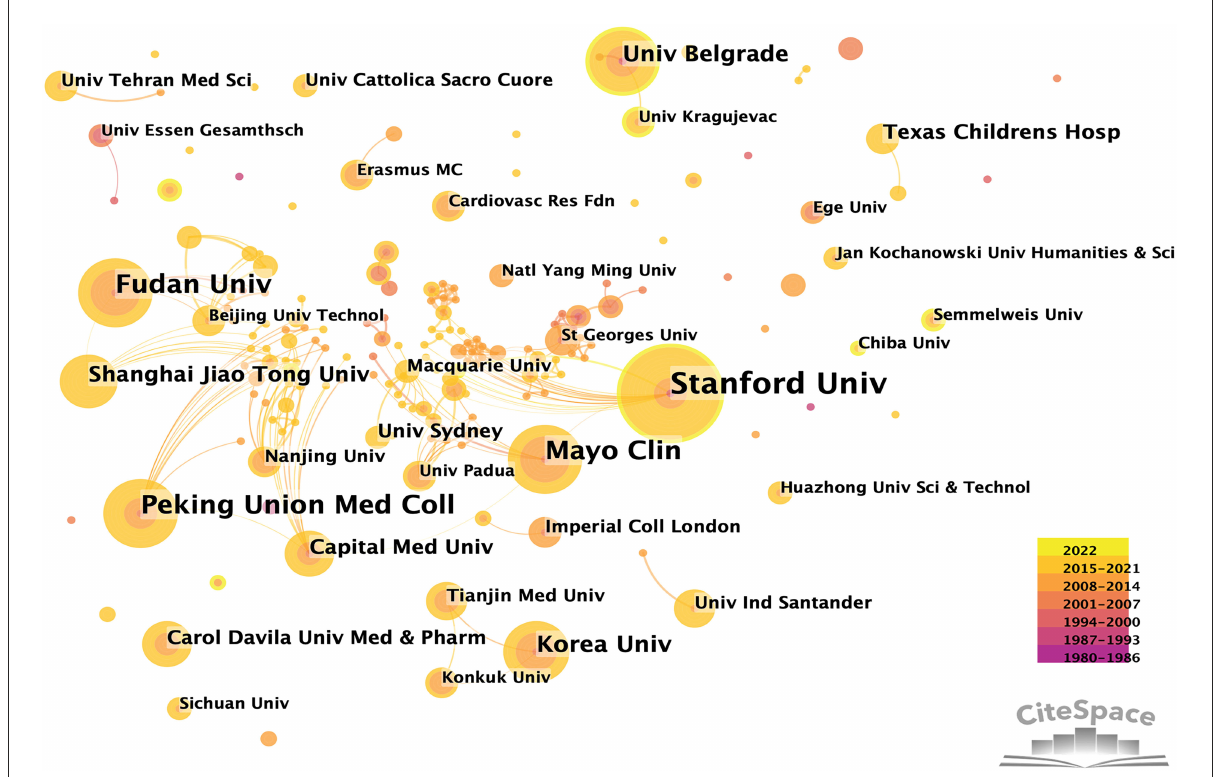
FIGURE2 Co-authorship between institutions with more than four